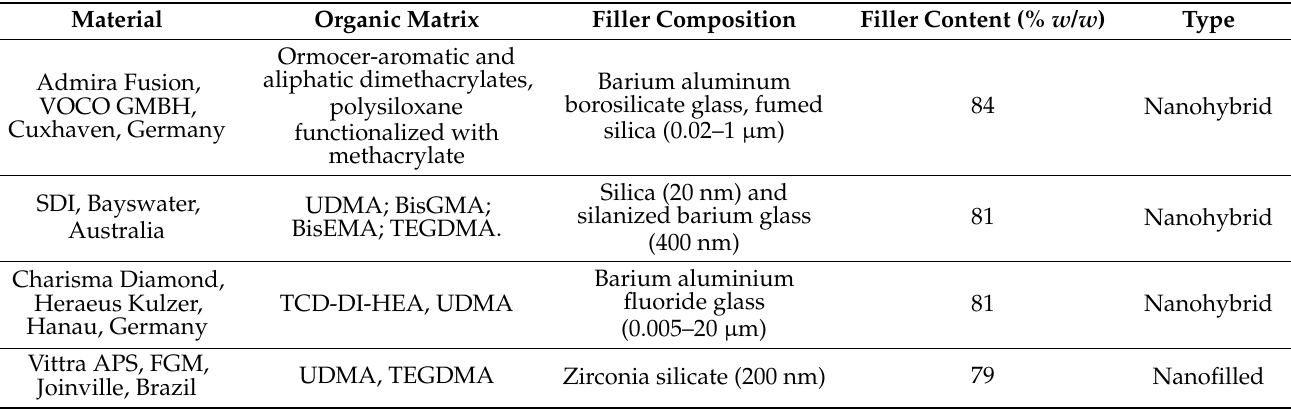
Table 1. Specifications of the tested composite